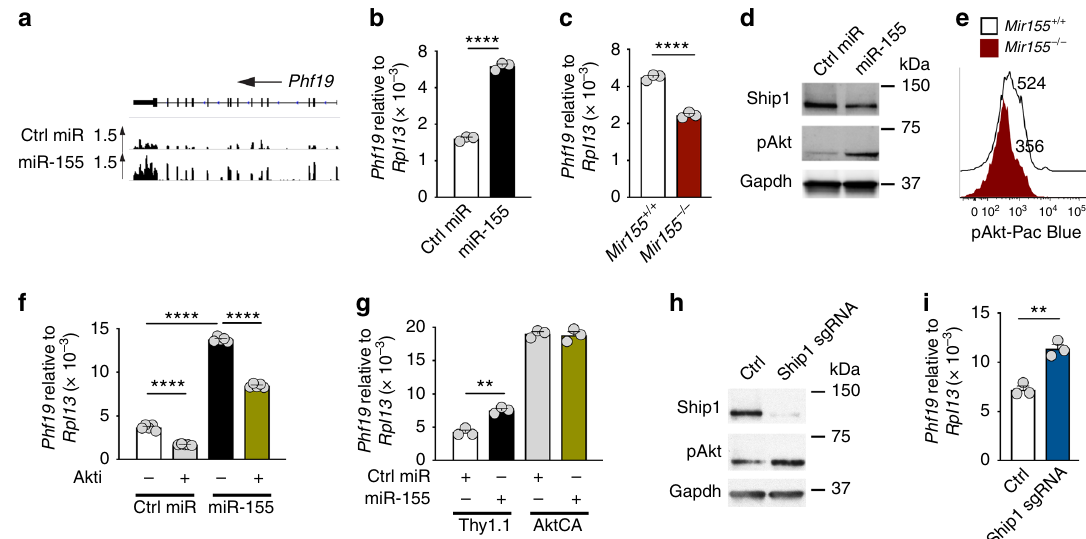
Fig. 4 miR-155 promotes Phf19 expression by enhancing Akt signaling via downregulation of Ship1. a , b RNA-seq reads ( a ) and quantitative RT-PCR ( b ) of Phf19 mRNA in miR-155 and Ctrl-miR-overexpressing cells. Bars (mean ± s.e.m. of technical triplicates) are relative to Rpl13 mRNA. c Quantitative RT-PCR of Phf19 mRNA in in vitro activated KLRG1 − miR-155 suf fi cient and de fi cient CD8 + T cells. Bars (mean ± s.e.m. of technical triplicates) are relative to Rpl13 mRNA. d Ship1 and pAkt levels in miR-155-overexpressing cells assessed by Immunoblot. e pAkt levels of in vitro activated KLRG1 − miR-155 suf fi cient and de fi cient CD8 + T cells assessed by fl ow cytometry. f , g Quantitative RT-PCR of Phf19 mRNA in ex vivo sorted CD8 + T cells overexpressing miR-155 and Ctrl-miR after a 6 h incubation with or without AKT inhibitor VIII (Akti) ( f ) or transduction with constitutively active Akt (AktCA) or Thy1.1 control ( g ). Bars represent the mean ± s.e.m. of technical triplicates. h Ship1 and pAkt levels in Cas9 + CD8 + T cells transduced with Ship1-speci fi c gRNA assessed by Immunoblot. i Quantitative RT-PCR of Phf19 mRNA in Cas9 + CD8 + T cells transduced with Ship1-speci fi c gRNA or control. Bars represent the mean ± s.e.m. of technical triplicates. Data are representative of two independent experiments. * P < 0.05; ** P < 0.01; **** P < 0.001 (unpaired two-tailed Student ’ s t